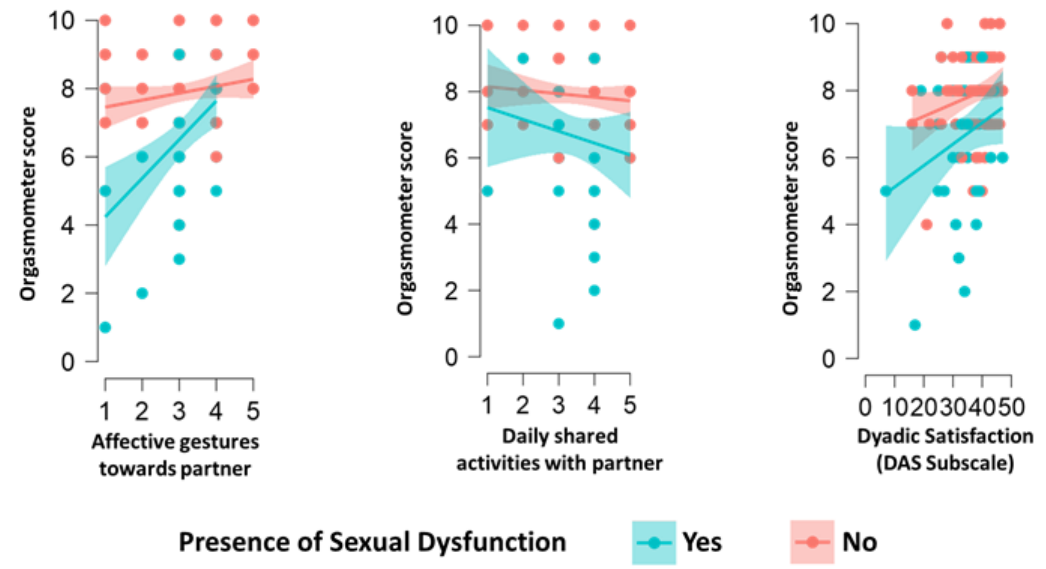
Figure 1. The relationship between Orgasmometer scores and specific variables according to ANCOVA analysis (the boundaries for the colored areas surrounding the lines represent standard errors, (SE)).